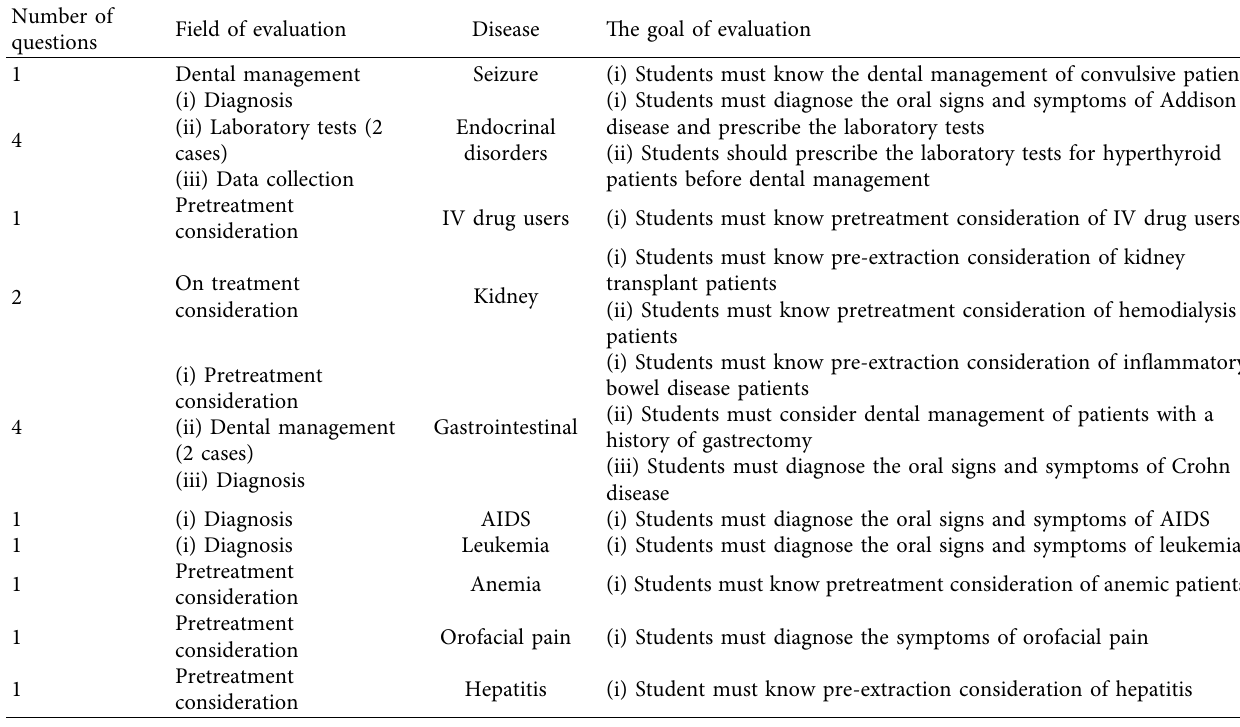
Table 1: The detail of key feature examination.